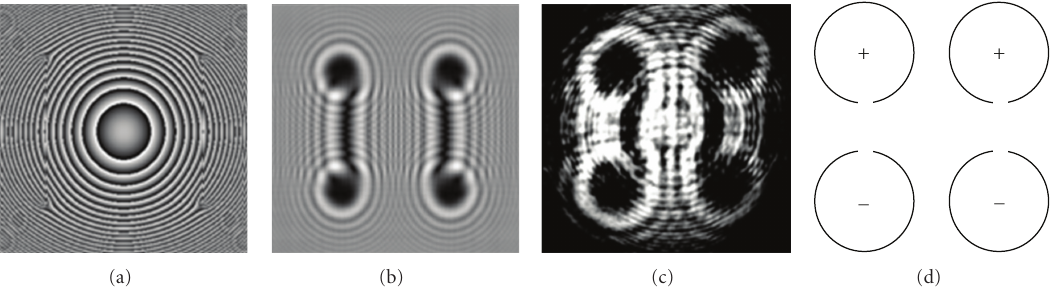
Figure 8: Fresnel lens with 2 × 2 lattice of fractional vortices with two positive and two negative topological charge vortices, each of magnitude 3.5 embedded at o ff -axis locations. (a) Phase distribution displayed on SLM. (b) Simulated intensity pattern near the focal plane. (c) Experimentally observed intensity distribution near the focal plane. (d) Distribution of topological charge in the intensity